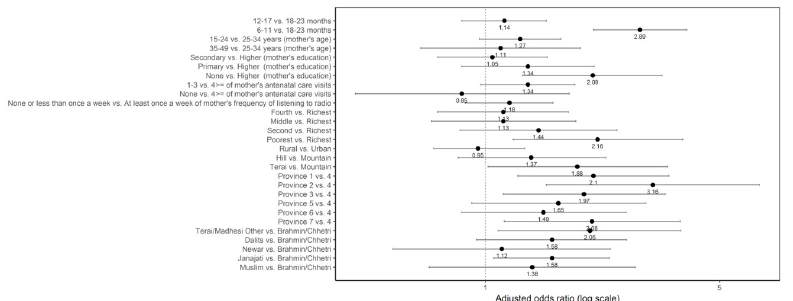
Fig 15. Odds ratio plot with 95% confidence intervals for not consuming other fruits and vegetables among Nepalese children aged 6 to 23 months.